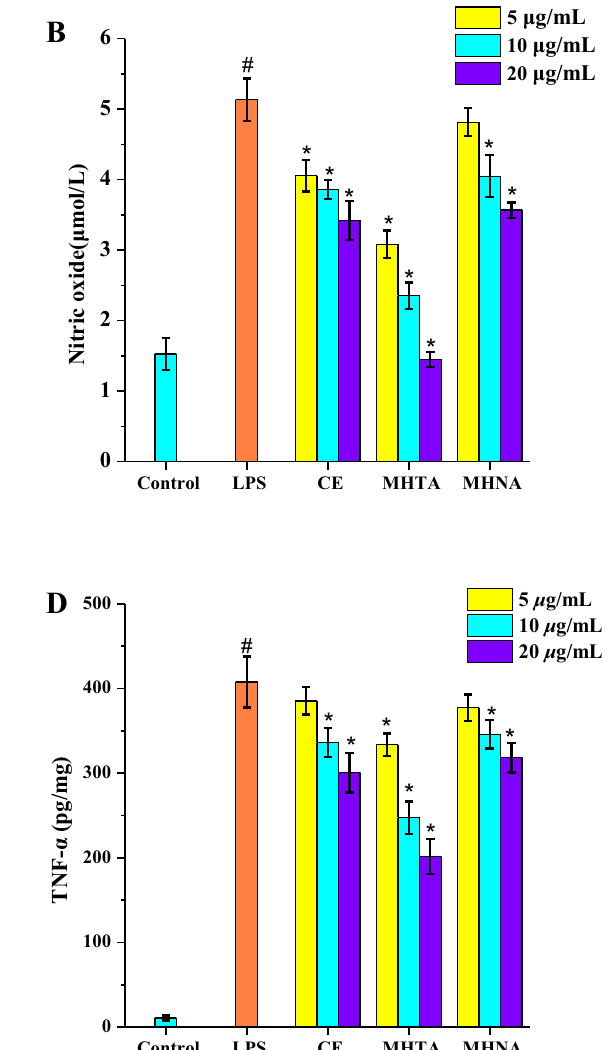
TNF-α. Data represent mean ± SD, n = 3. # p < 0.05, means significant difference from the control group.* p < 0.05, means significant differ- ence from the LPS